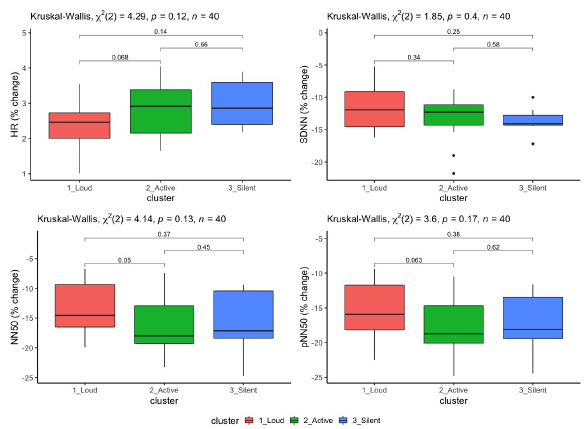
Figure 6: Relative change (%) in time domain HRV parameters for different soundscape